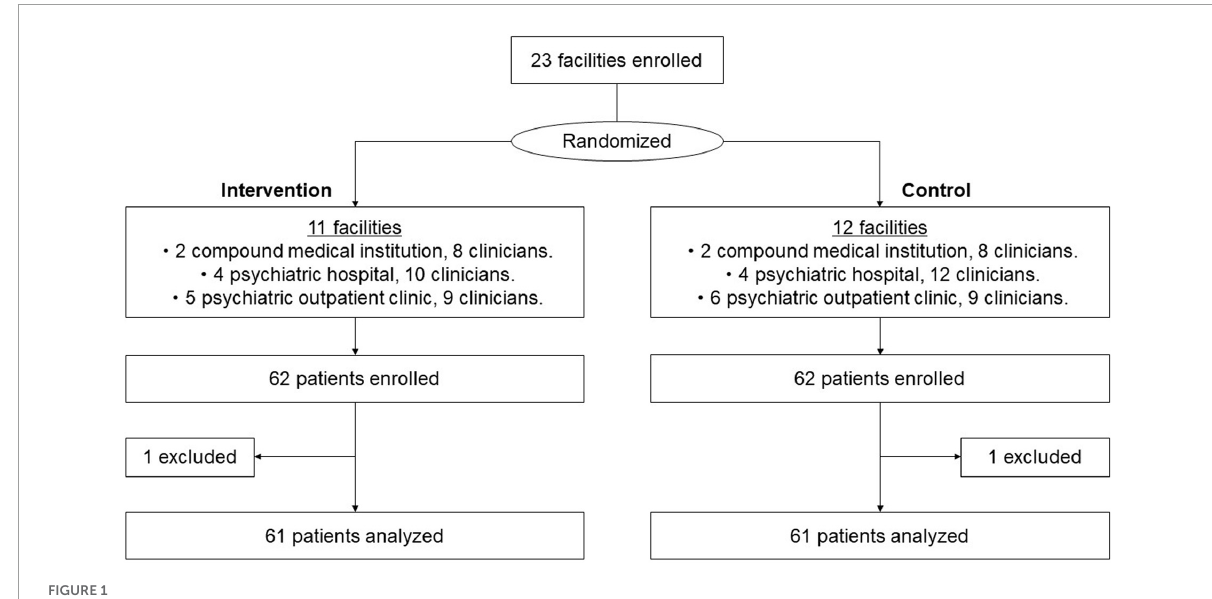
FIGURE1 CONSORT flow